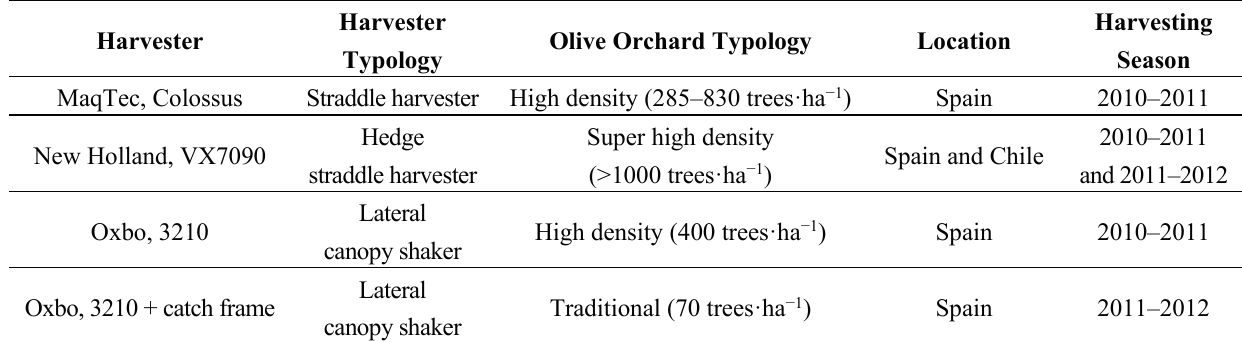
Table 1. Detailed description of the tracked harvesters, and commercial field